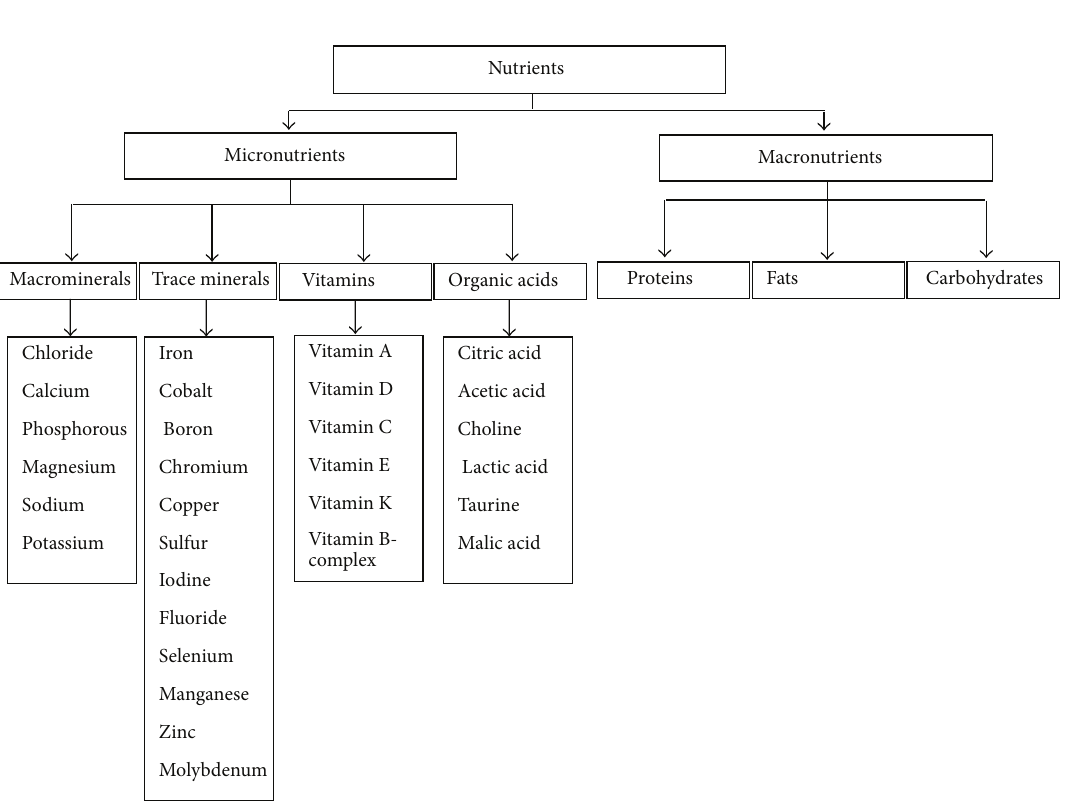
Figure 1: Classification of different nutrients need in metabolism.